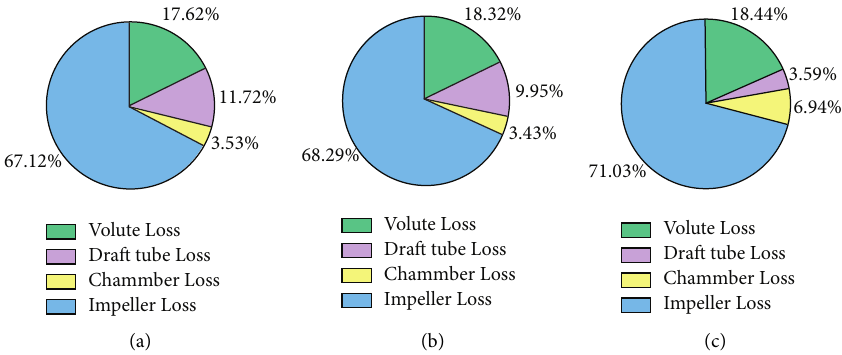
Figure 11: Loss ratio distribution of turbine under design condition. (a) n � 18000r/min. (b) n � 20000r/min. (c) n � 22000r/min.